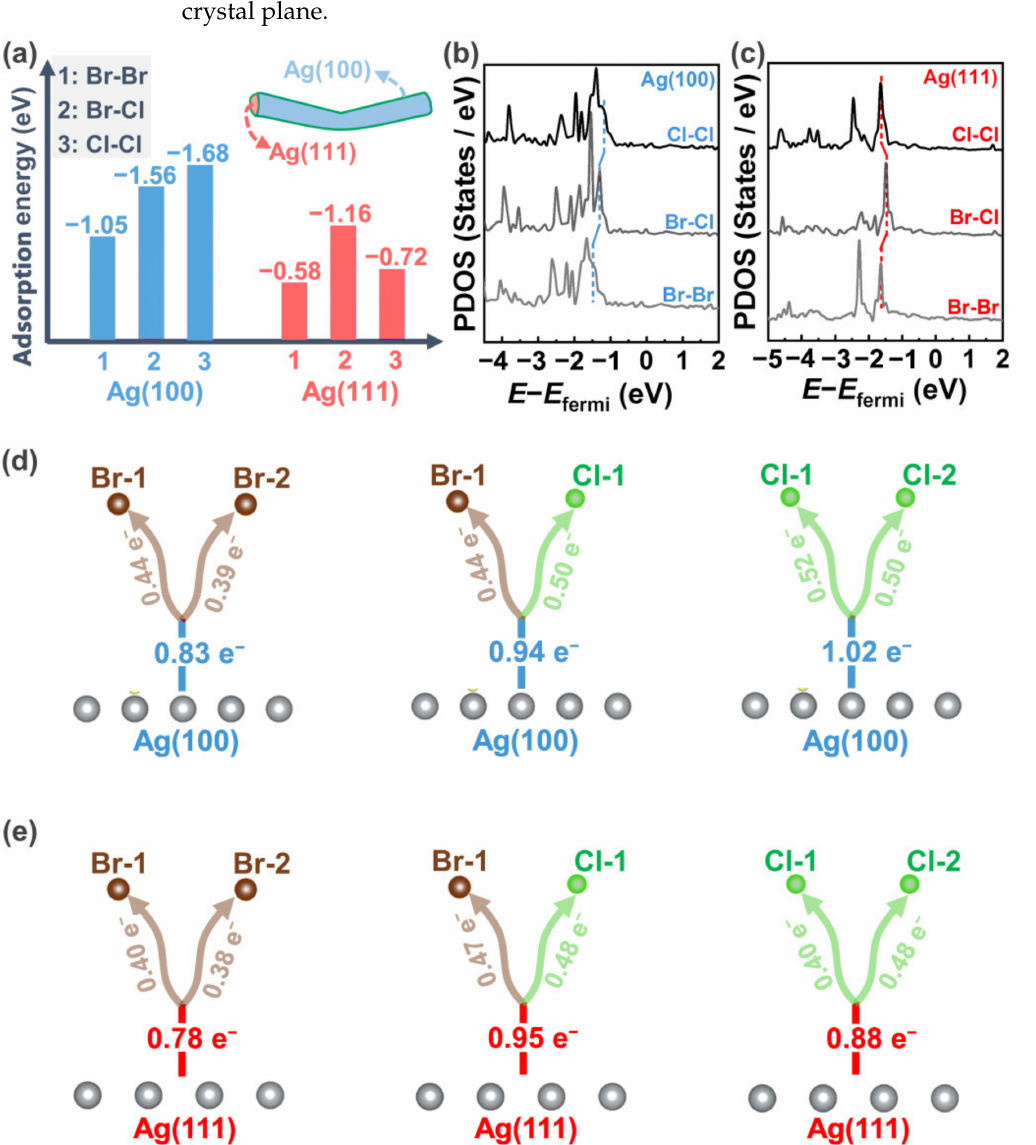
Figure 5. ( a ) Comparison of adsorption energies of halogens on Ag(100) and Ag(111) crystal planes. ( b , c ) Partial density of states (PDOS) of silver atoms on Ag(100) and Ag(111) crystal plane. ( d , e ) Bader charge distribution diagram of Ag(100) and Ag(111) crystal planes. The insets in ( a ) illustrates a schematic diagram of a single